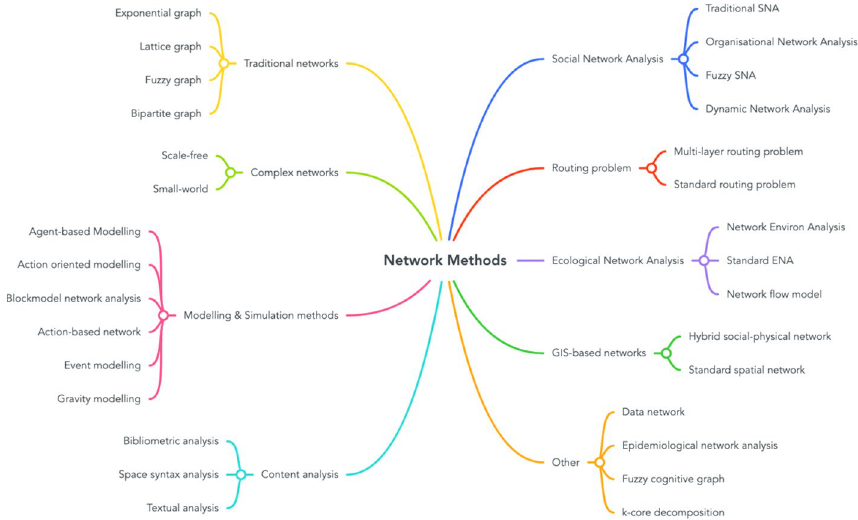
Fig. 4 Map of identified network methods according to